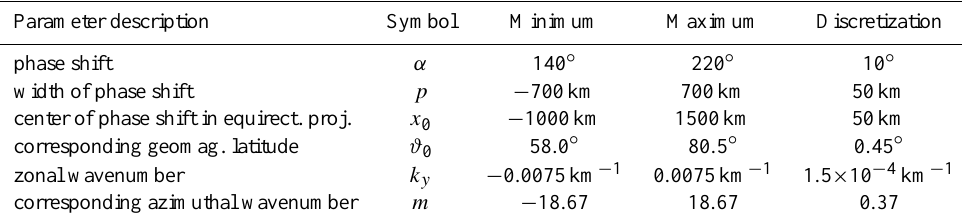
Table 2. Intervals in parameter space, which determine the scanning area for the FLRD application: Shown are minimum and maximum for each parameter and the discretization